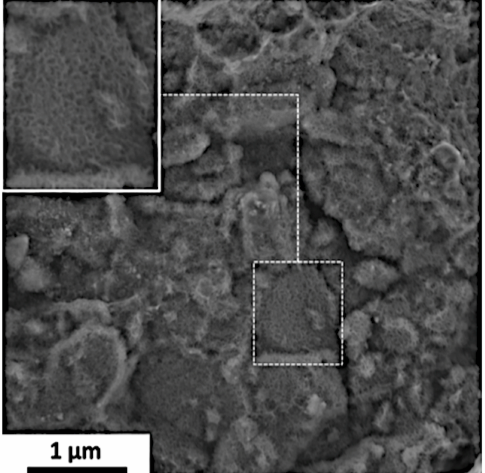
Figure 6. SEM micrograph of the fracture surface in the center of the spall plane revealing nanovoids at the interface between the intermetallic inclusions and the magnesium matrix. The solid box is an enlarged area of the small box